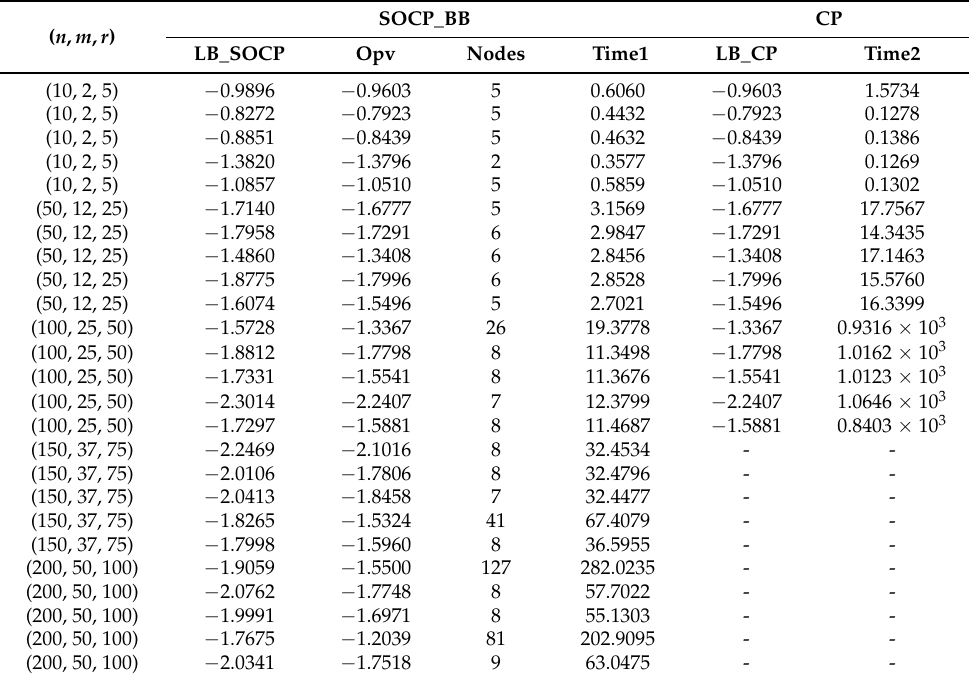
Table 2. Performance Comparisons of the enhanced SOCP relaxation and the CP relaxation with (cid:99) . (cid:99) and r = (cid:98) n m = (cid:98) n 2 4